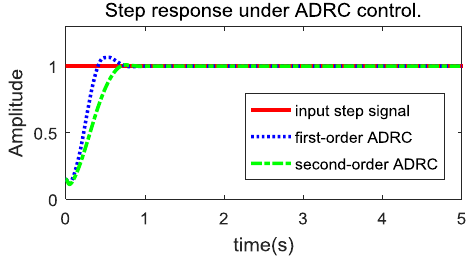
Figure 9. Step response under first-order ADRC and second-order ADRC.